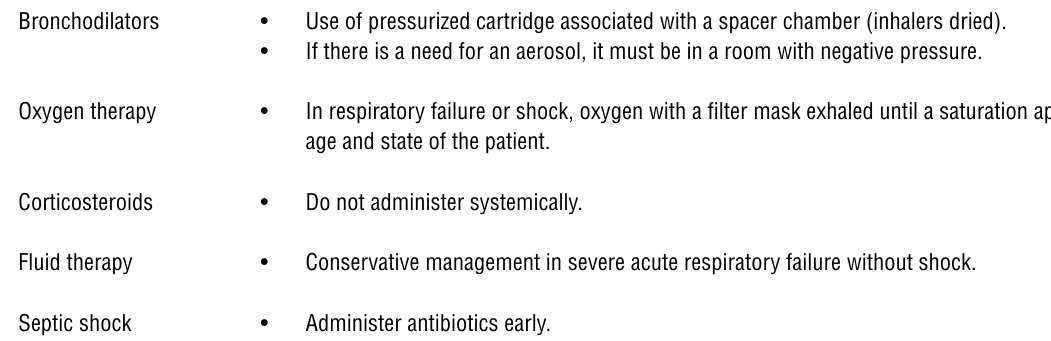
Table 5 - MSCBS. Emergency treatment in patients with COVID-19. April 2020 (8).